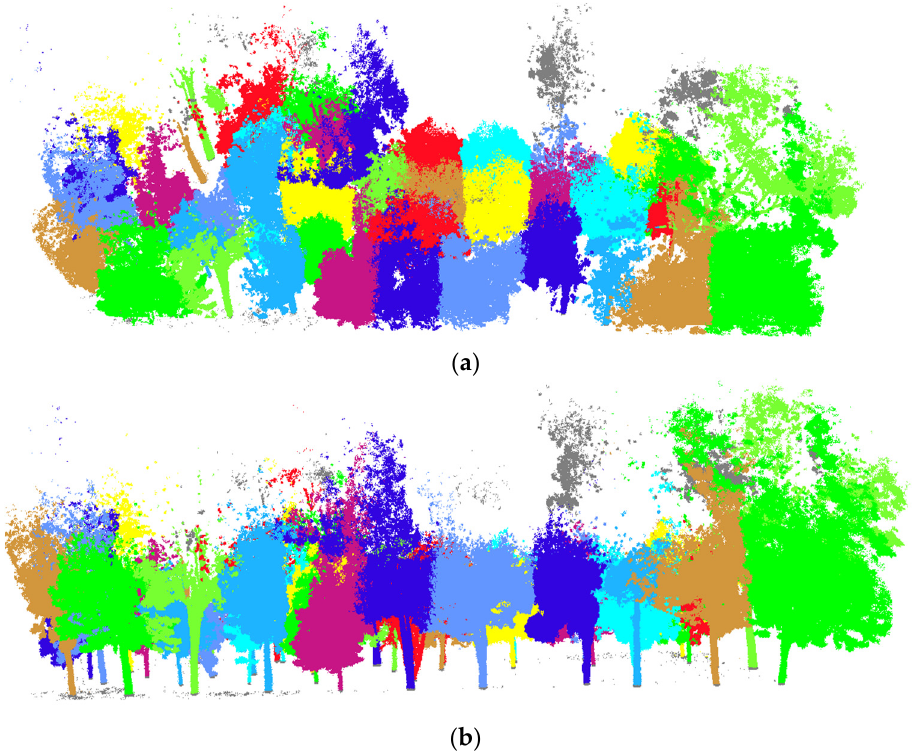
Figure 16. Single tree segmentation diagram. (( a ) top view; ( b ) front view). Table 1. Different parameters of single tree